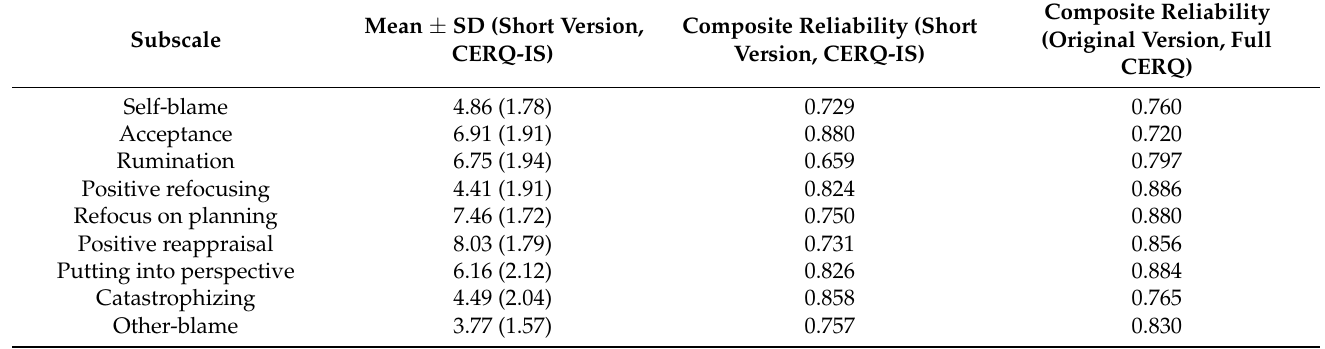
Table 2. Descriptive statistics for CERQ-IS subscales, and composite reliability coefficients based on both short and full versions of the CERQ for the sake of comparison. Abbreviations: CERQ, cognitive emotion regulation questionnaire; CERQ-IS, Italian short version of the cognitive emotion regulation questionnaire; SD, standard